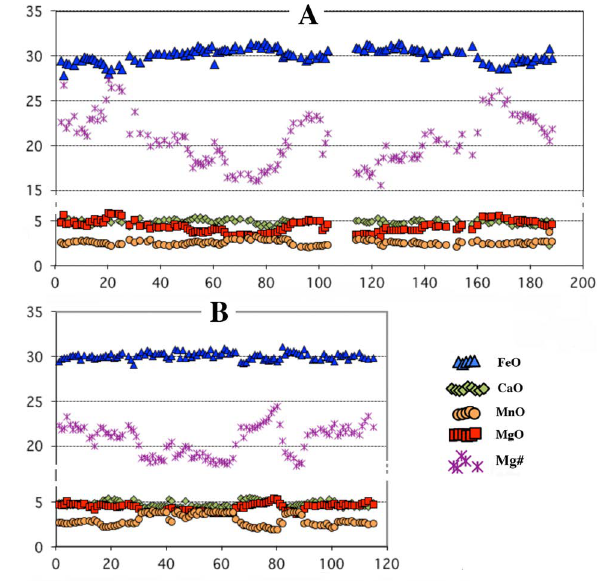
Figure 8: Compositional profiles from rim to rim across the two garnet megacrysts shown in Figure 6A and 6B. Spacing between analysis points for both profiles is 50 microns, except where interrupted by cracks or inclu- sions. Analyses plotted as weight % oxides : FeO = blue triangles , MgO = red squares, CaO = green diamonds, MnO = orange circles, Mg# = purple crosses (Mg# = Mg/Fe ` Mg in the structural formulae, all Fe calculated as Fe + ). 2